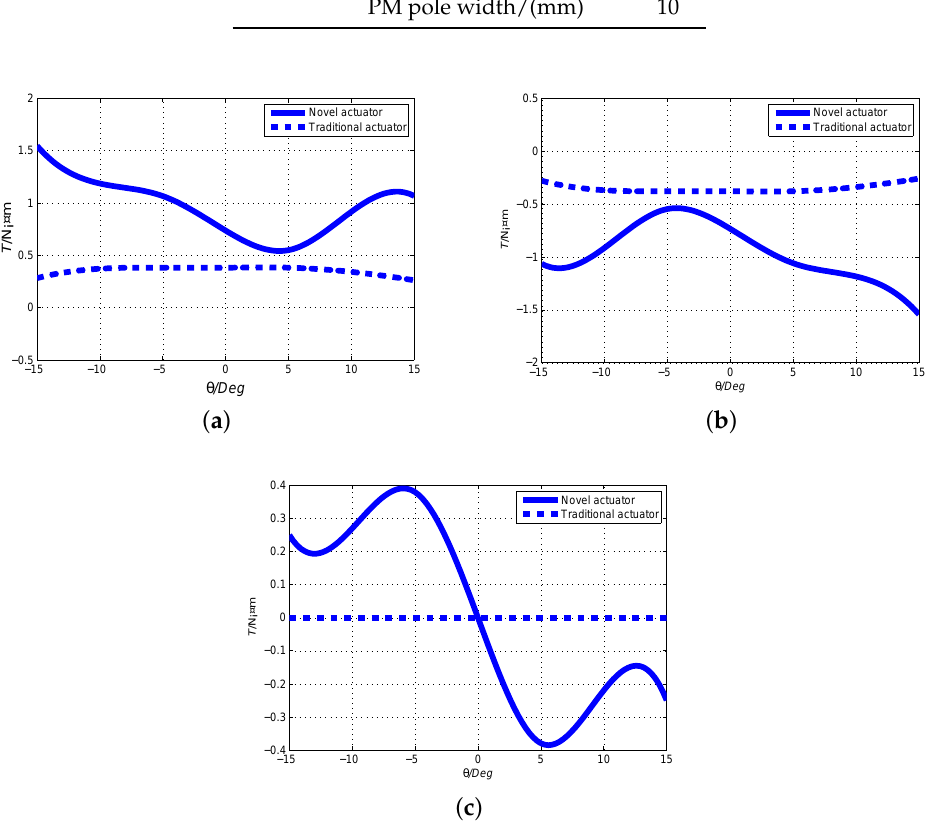
Figure 9. Comparison of output torque between 2D camber Halbach array and traditional PM array. ( a ) Output torque T o + when current direction is positive; ( b ) Output torque T o − when current direction is negative; ( c ) Output cogging torque T f